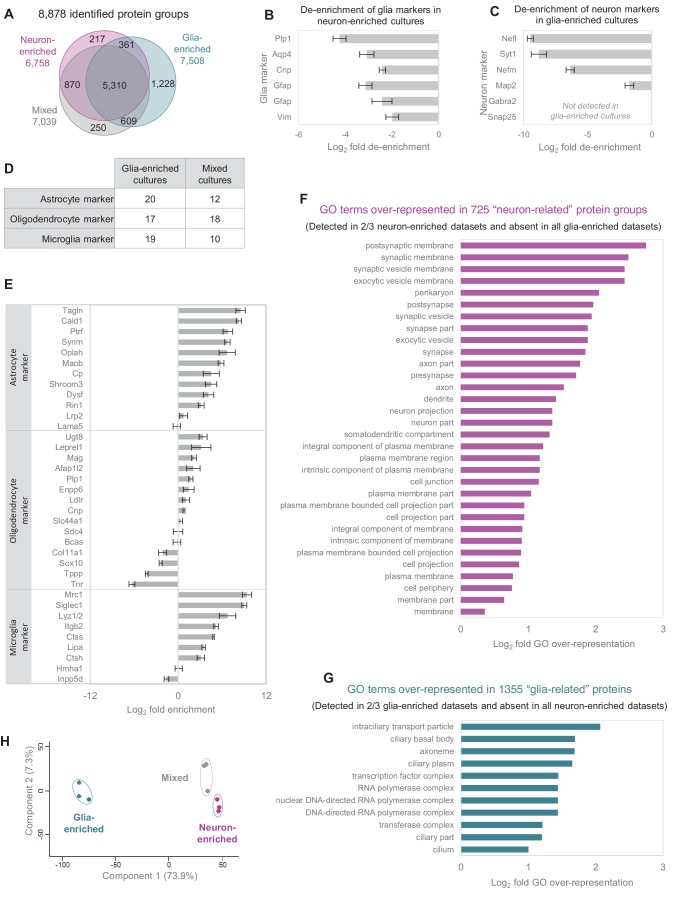
Comparison of different culture types.(A) Number of identified protein groups in the different culture types. (B) Established glia markers are de-enriched in neuron-enriched cultures. Bar diagram shows log2 fold change between neuron-enriched cultures and mixed cultures and error bars indicate SEM. (C) Established neuron markers are de-enriched in glia-enriched cultures. Bar diagram shows log2 fold change between glia-enriched cultures and mixed cultures and error bars indicate SEM. (D) Number of quantified astrocyte, oligodendrocyte and microglia marker proteins in glia-enriched versus mixed cultures. (E) Comparison of relative protein expression levels of astrocyte, oligodendrocyte and microglia markers in glia-enriched cultures versus mixed cultures. Error bars show the standard deviation. (F) GO over-representation analysis for 725 ‘neuron-related’ protein groups (detected in ≥2 biological replicates in neuron-enriched cultures and never detected in glia-enriched cultures). (G) GO over-representation analysis for 1,355 ‘glia-related’ protein groups (detected in ≥2 biological replicates in glia-enriched cultures and never detected in neuron-enriched cultures). (H) Different culture types form distinct clusters in a principle component analysis (PCA). For PCA, log2 transformed relative abundances of 3214 protein groups, which were detected in all biological replicates of all culture types, were used.